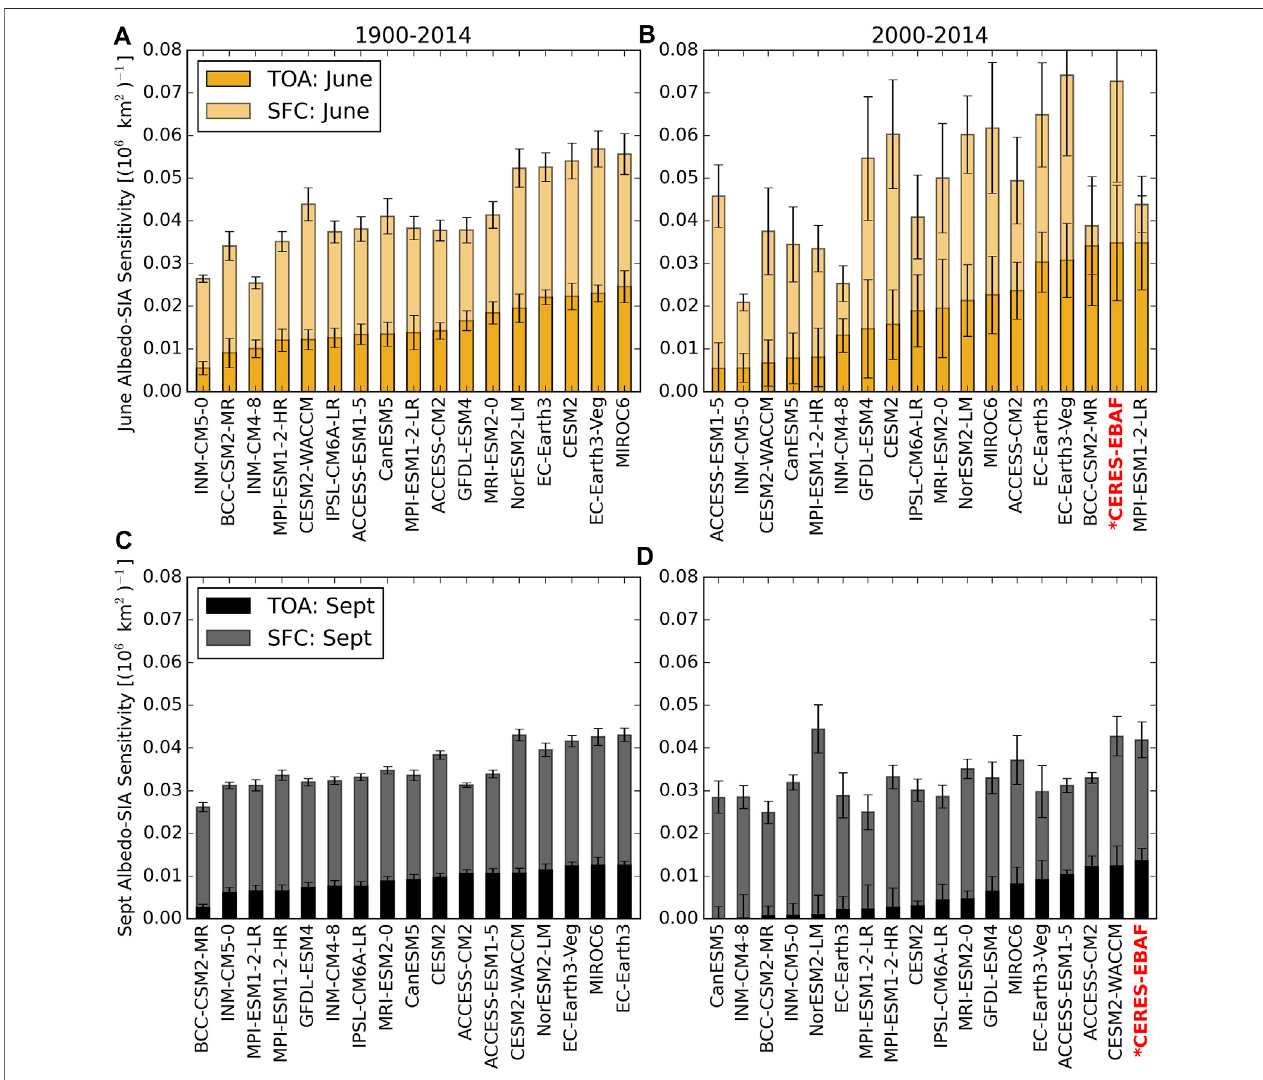
FIGURE5| Sensitivity ofTOAand surfacealbedos toseaice area(SIA) inJune (A , B) and September (C , D) .Sensitivityisfound fromtheregression ofeach albedo against SIA for a given month across the historical time period, 1900 – 2014 (A , C) and the overlap with the CERES observational record, 2000 – 2014 (B , D) . Models are sorted from lowest (left) to highest (right) TOA sensitivity to SIA. Error bars represent the standard error of the estimated gradient for each sensitivity.